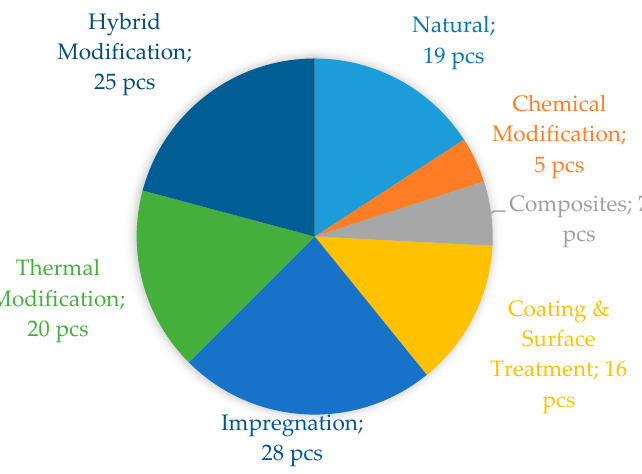
Figure 1. Groups of materials evaluated. [4,17].